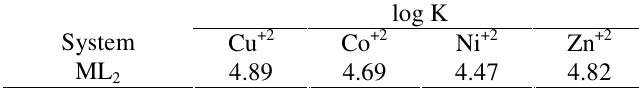
Table 1 . Logarithm of stability constants assembling for the interaction of metal ions with the TBA at T = 25 o C, ionic strength of 0.2(w/v) NaCl and pH = 6 in deionized